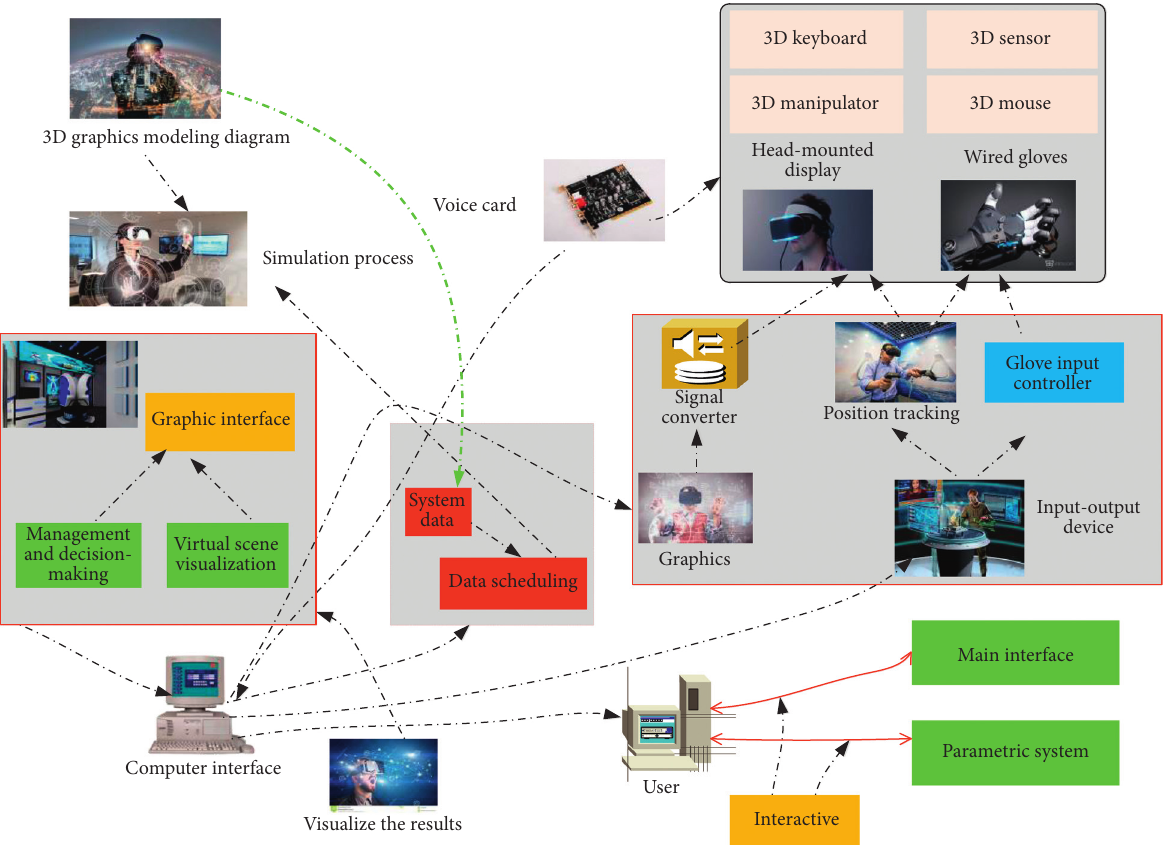
Figure 1: The composition of the virtual reality